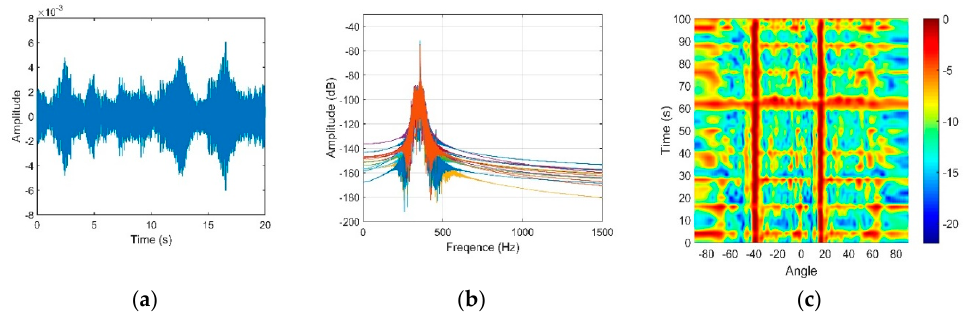
Figure 24. ( a ) Signal waveform; ( b ) Signal frequency through a narrow bandpass filter; ( c ) Beam output of the signal.